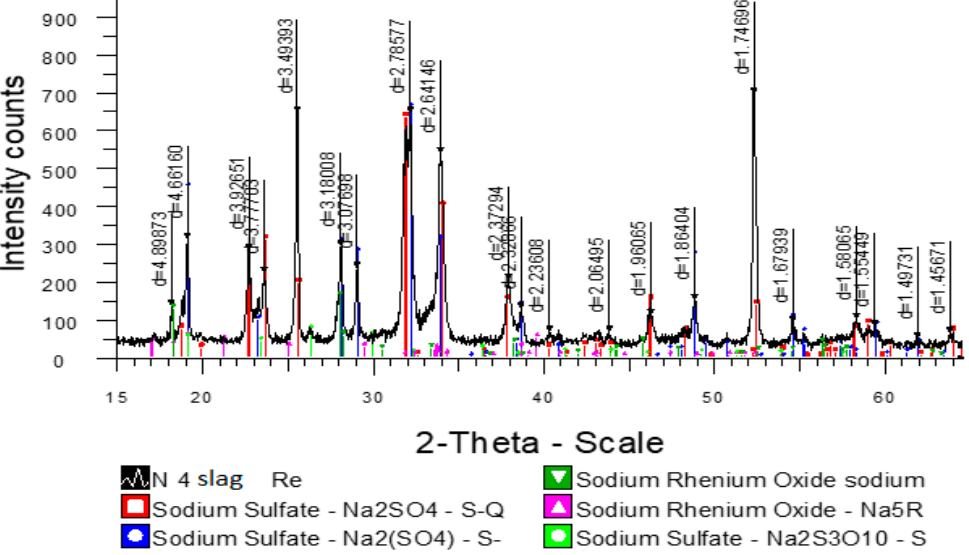
Figure 6. Diffraction pattern of sodium sulfate slag.